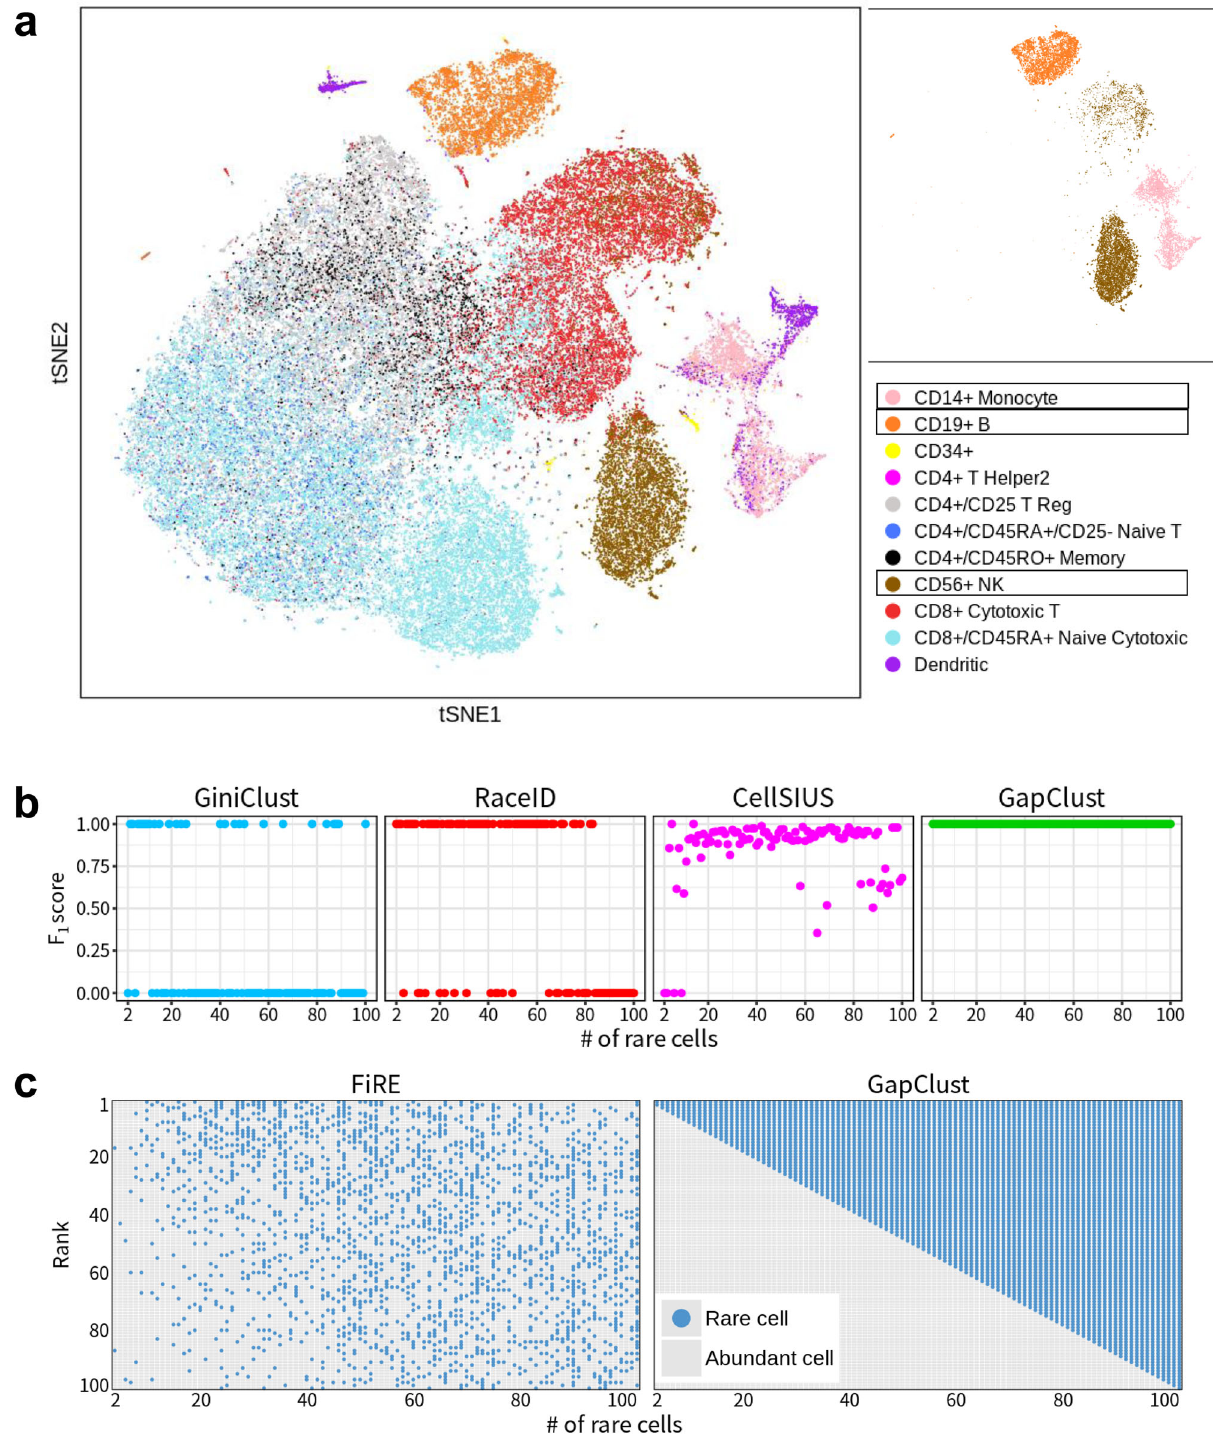
Fig. 2 Analysis of the simulated datasets subsampled from the 68 k PBMC dataset. a The tSNE plot of the full dataset with reference labels (left), along with the three cell types selected for analysis (right). b Evaluation of the performance of different methods for rare cell type detection, quanti fi ed by F 1 score. c Comparison of the ranking results for rare cells between GapClust and FiRE by continuous